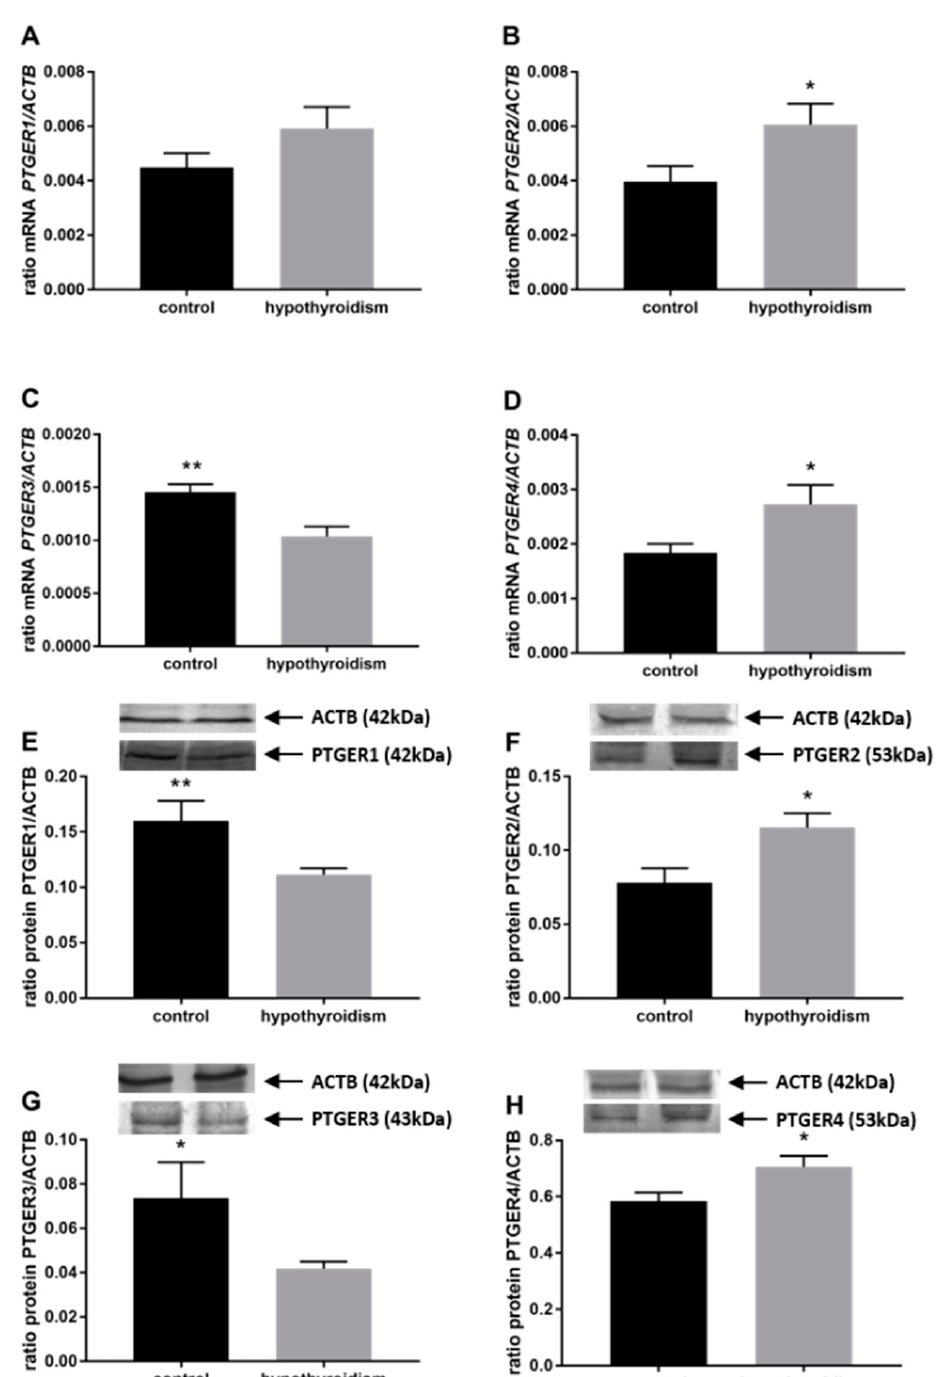
Figure 6. The effects of hypothyroidism on the mRNA and protein abundance of PGE 2 receptors in the uterine tissue of rats: ( A , E ): PTGER1/PTGER1; ( B , F ): PTGER2/PTGER2; ( C , G ): PTGER3/PTGER3; ( D , H ): PTGER4/PTGER. The values are presented in arbitrary units and expressed as the mean ± SEM. Stars indicate significant differences (* p ≤ 0.05, ** p ≤ 0.01, *** p ≤ 0.001, **** p ≤ 0.0001), as determined by Student’s t -test.